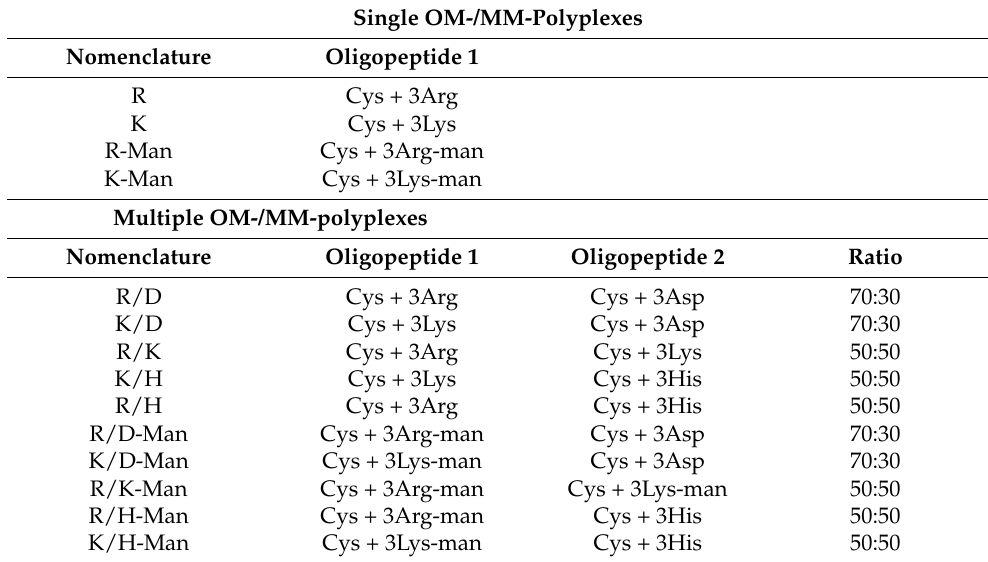
Figure 1. Synthesis of mannose-modified PBAEs derived from the C6 polymer. Decoration of the tri-arginine-modified PBAE is shown as an example. ( i ) Synthesis of the acrylate-terminated C6 PBAE via Michael addition. ( ii ) End-capping of the C6 polymer with oligopeptide moieties and mannosylation of oligopeptide-terminated PBAEs. R’ corresponds to predicted mannose targeting. Table 1. List of screened polyplexes derived from single or multiple OM- and MM-PBAEs (Man =